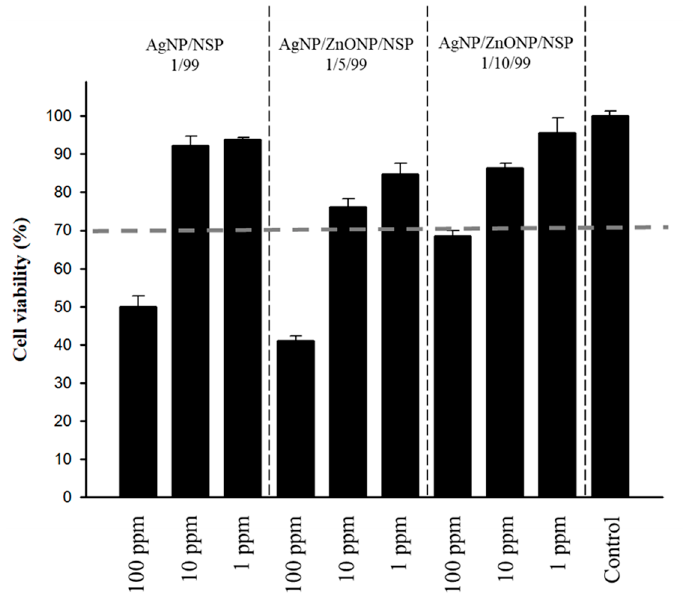
Figure 7. Mammalian cytotoxicity of AgNP/NSP (1/99, w / w ) and AgNP/ZnONP/NSP (1/5/99 and 1/10/99, w / w / w ) at 1 ppm, 10 ppm, and 100 ppm. According to ISO 10993-5, the safety level (70% 3T3 fibroblast cell viability) is indicated by the dashed gray line. Table 1. Minimum bactericidal concentrations (MBC) of NSP, ZnONP/NSP (15/85, w / w ), AgNP/NSP